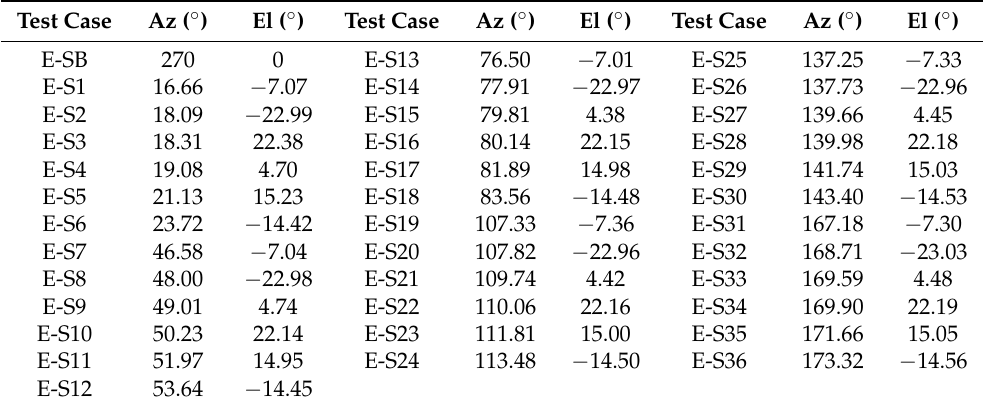
Table 7. Summary of test cases with variable illumination conditions for the pose estimation with the eye-in-hand camera.